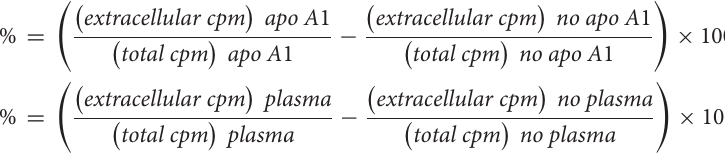
efflux ( Figure 1D ) as plasma containing HDL particles served as cholesterol acceptors in the process of cholesterol